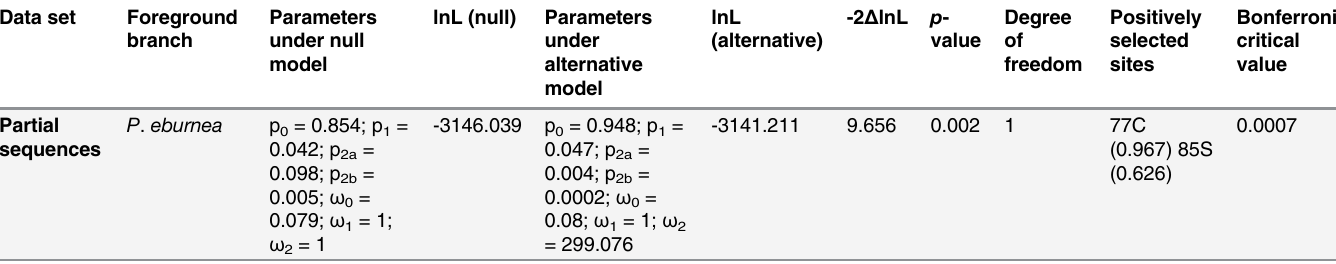
Table 4. PAML branch-sie model A analysis to identify branches under episodic positive selection.